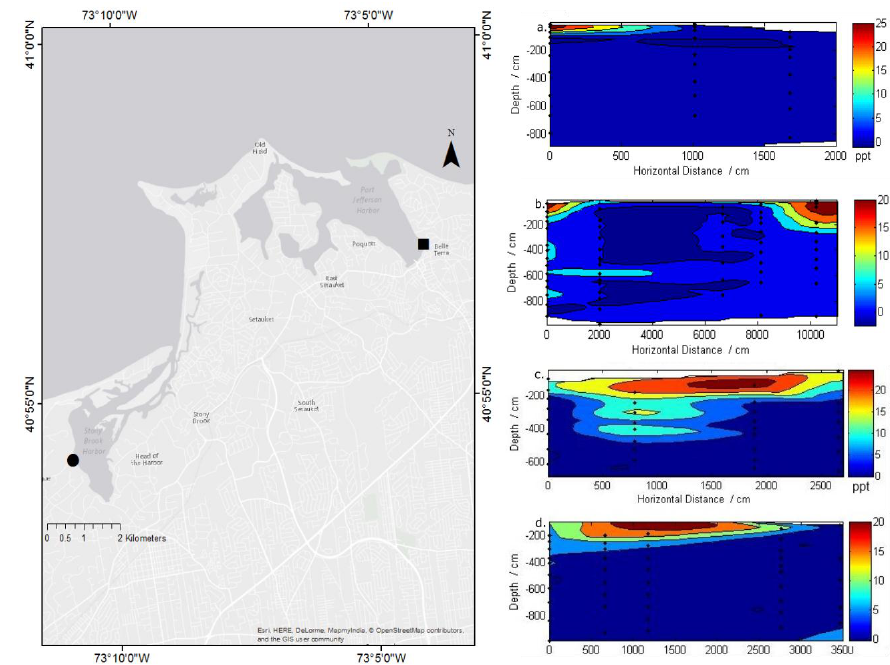
Figure 1. Site map of Port Jefferson Harbor coastal aquifer (▪) and Stony Brook Harbor (SBH) coastal aquifer (●) located on embayment’s of Long Island Sound ( left ). Cross section of salinity at Port Jefferson Harbor during ( a ) May 2011 and ( b ) October 2011 and Stony Brook Harbor in ( c ) May 2011